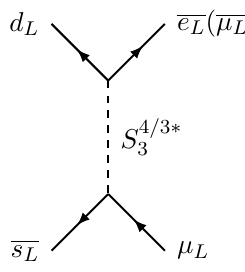
! e(cid:22) ( K 0 ! (cid:22)(cid:22) L L